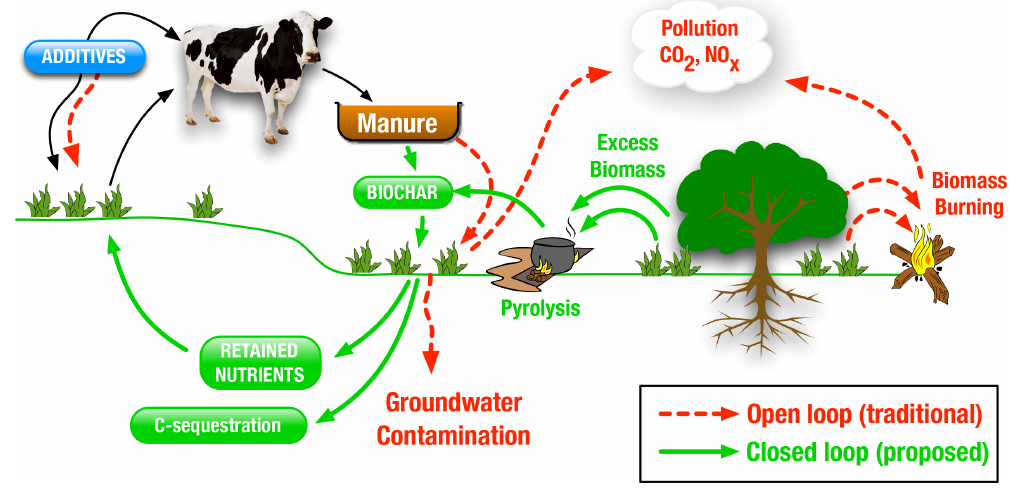
Figure 1. Schematic representation of the components and overarching goal of the approach to use biochar to extract nutrients from dairy